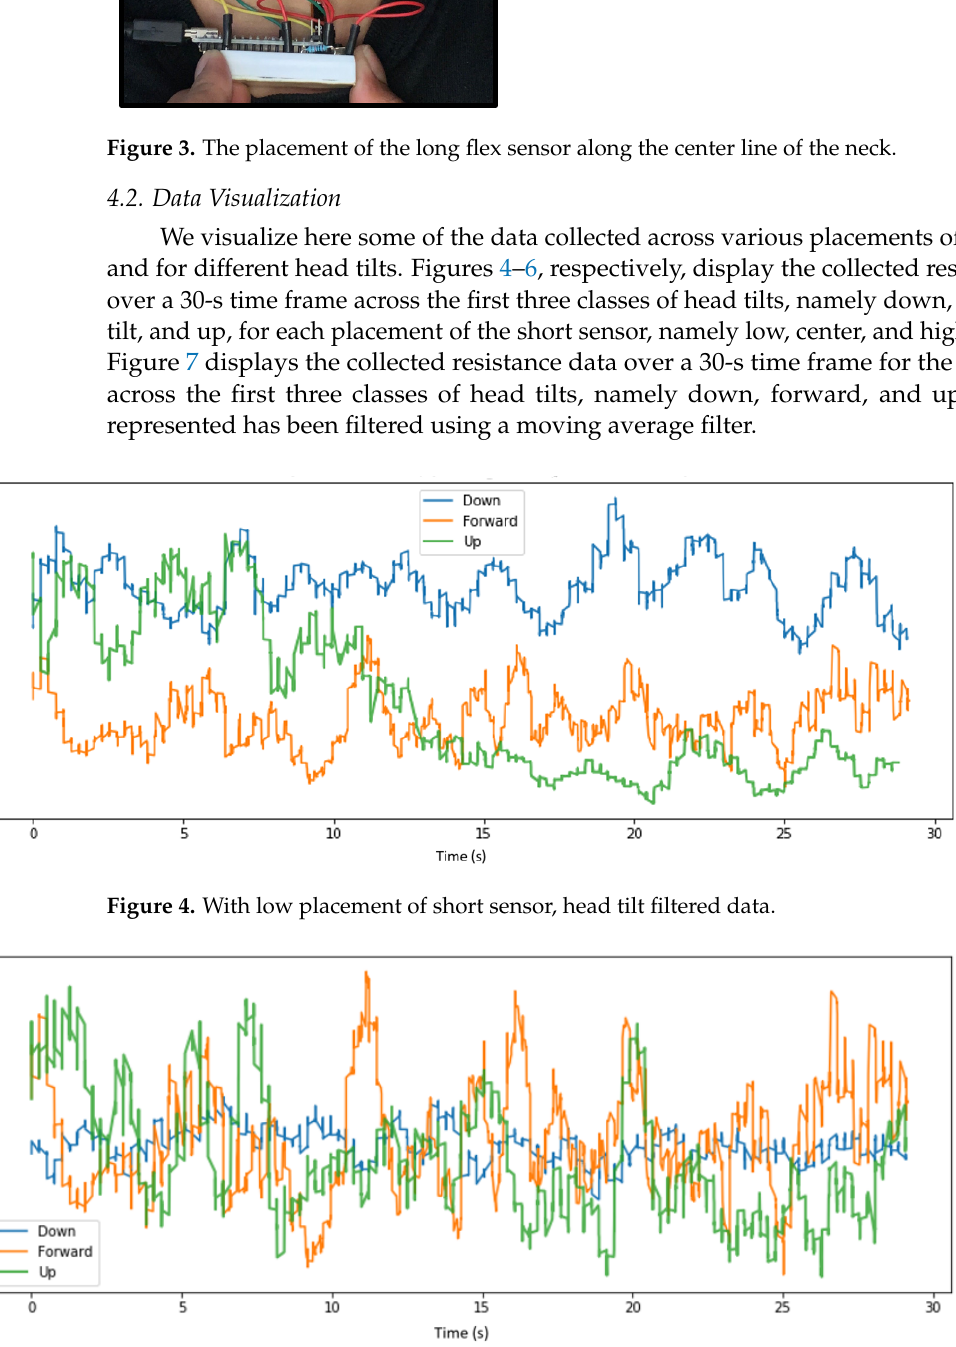
Figure 3. The placement of the long flex sensor along the center line of the neck.